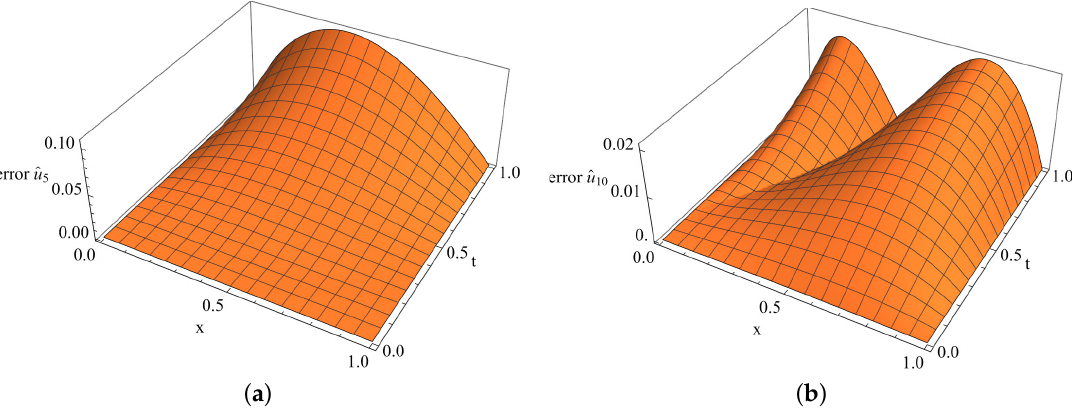
Figure 3. Approximation errors of (cid:98) u 5 ( a ) and (cid:98) u 10 ( b